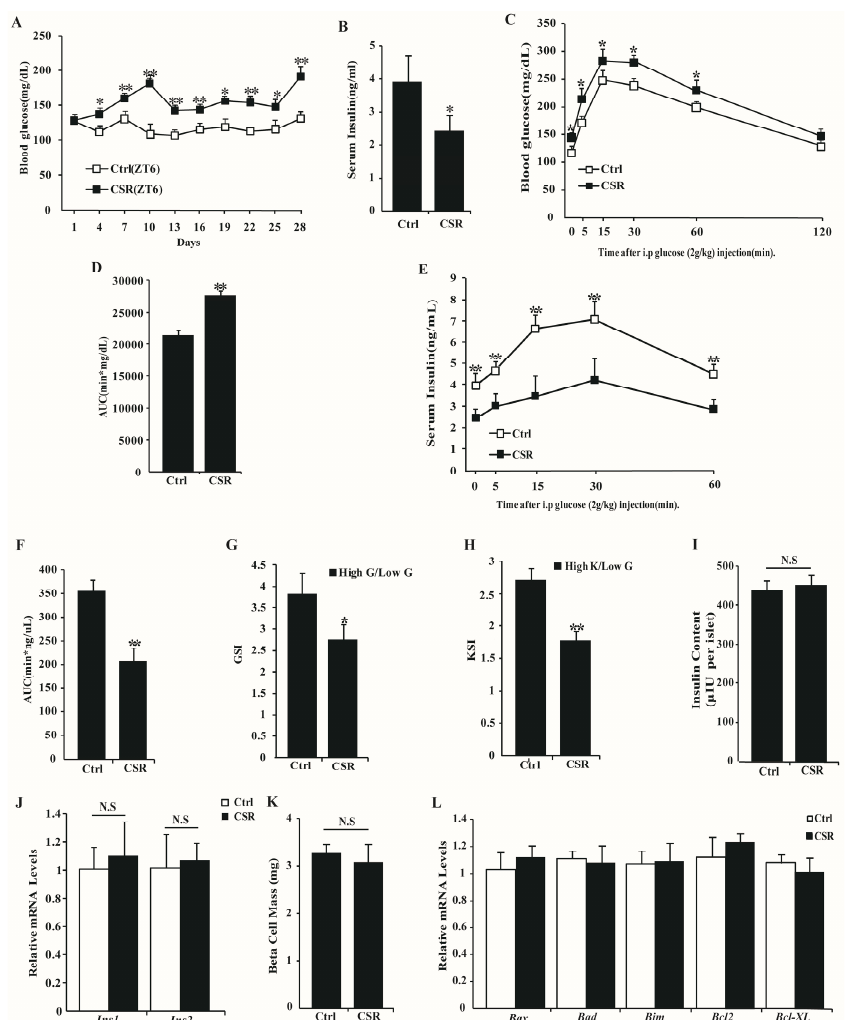
Figure 5. Chronic sleep restriction impaired islet function: ( A ) Fasting blood glucose of control and CSR rats were monitored during chronic sleep loss ( n = 10); ( B ) Fasting serum insulin of control and CSR rats were measured after chronic sleep disturbance ( n = 10); ( C ) IPGTTs were performed at the end of CSR treatment (i.p = intraperitoneal, n = 5); ( D ) The AUC of ( C ); ( E ) Analysis of serum insulin levels during IPGTTs ( n = 5); ( F ) The AUC of ( E ). Isolated islets from control and CSR rats were analyzed for insulin secretion by incubation in response to stimulation with: 3.3 mM glucose (Low G ) ( G ); and 16.7 mM glucose (High G ) or 50 mM KCL (High K ) ( H ) ( n = 5); ( I ) Analysis of insulin content in isolated islets used in ( G ); ( J ) Relative mRNA levels of Ins1 and Ins2 in islets of control and CSR rats ( n = 5); ( K ) The mean β cell mass in islets ( n = 5); ( L ) Relative mRNA levels of genes involved in apoptosis pathways in islets ( n = 5). White squares = control group; black squares = CSR group. * p < 0.05, ** p < 0.01 vs. control. N.S = no significant change. The primary common process in GSIS and KSIS is insulin granule exocytosis. The last steps in this process are controlled by correct docking and fusion of insulin granules to the plasma membrane of pancreatic β cells. GSIS and KSIS were both decreased in CSR rats, which indicated